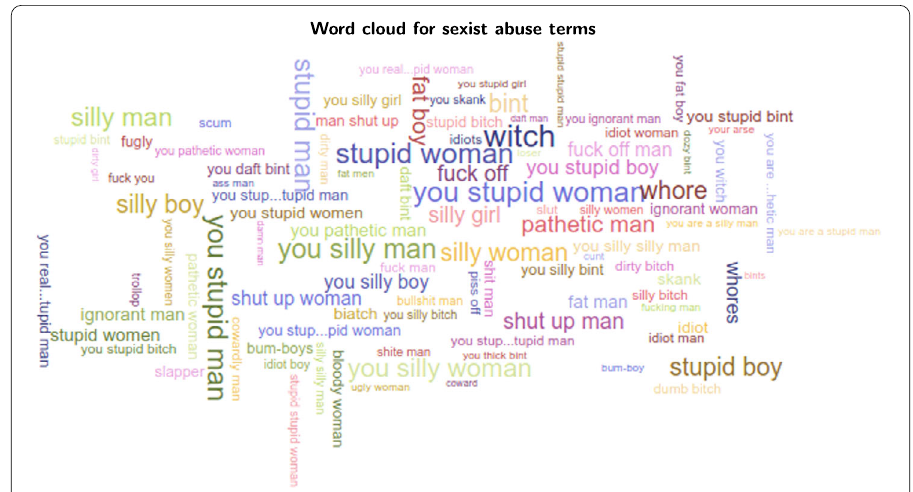
Figure 8 Word cloud for sexist abuse terms. Word cloud displaying the abuse terms most frequently found in tweets containing sexist abuse